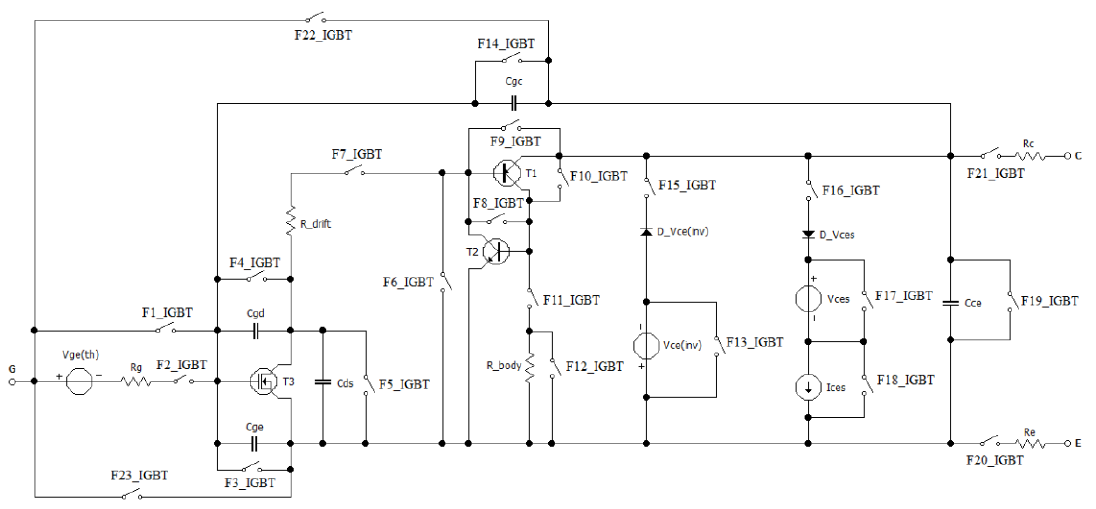
Figure 7. The faults considered inside the insulated gate bipolar transistor (IGBT) device.